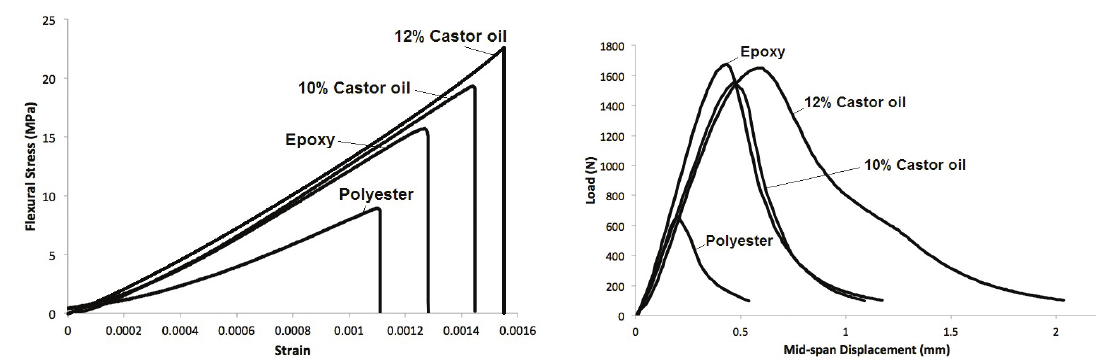
Figure 4. Typical load vs. mid-span displacement curves of castor oil and synthetic polymer